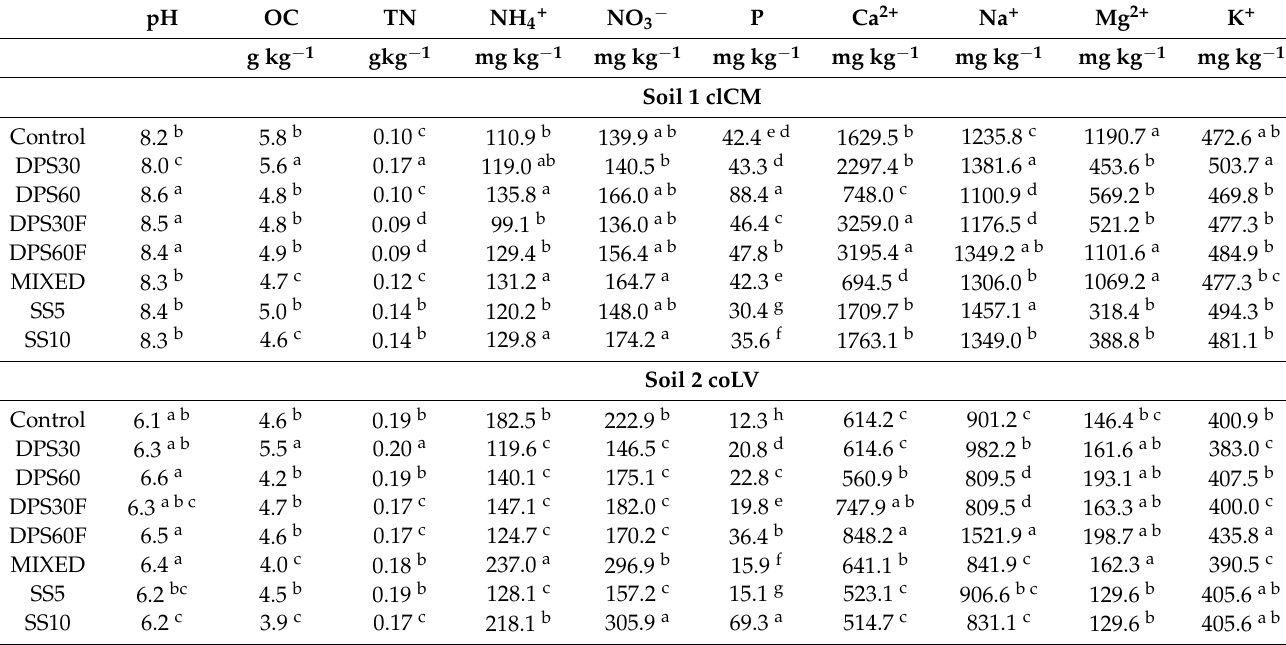
Table 4. DPS application effects on soil chemical